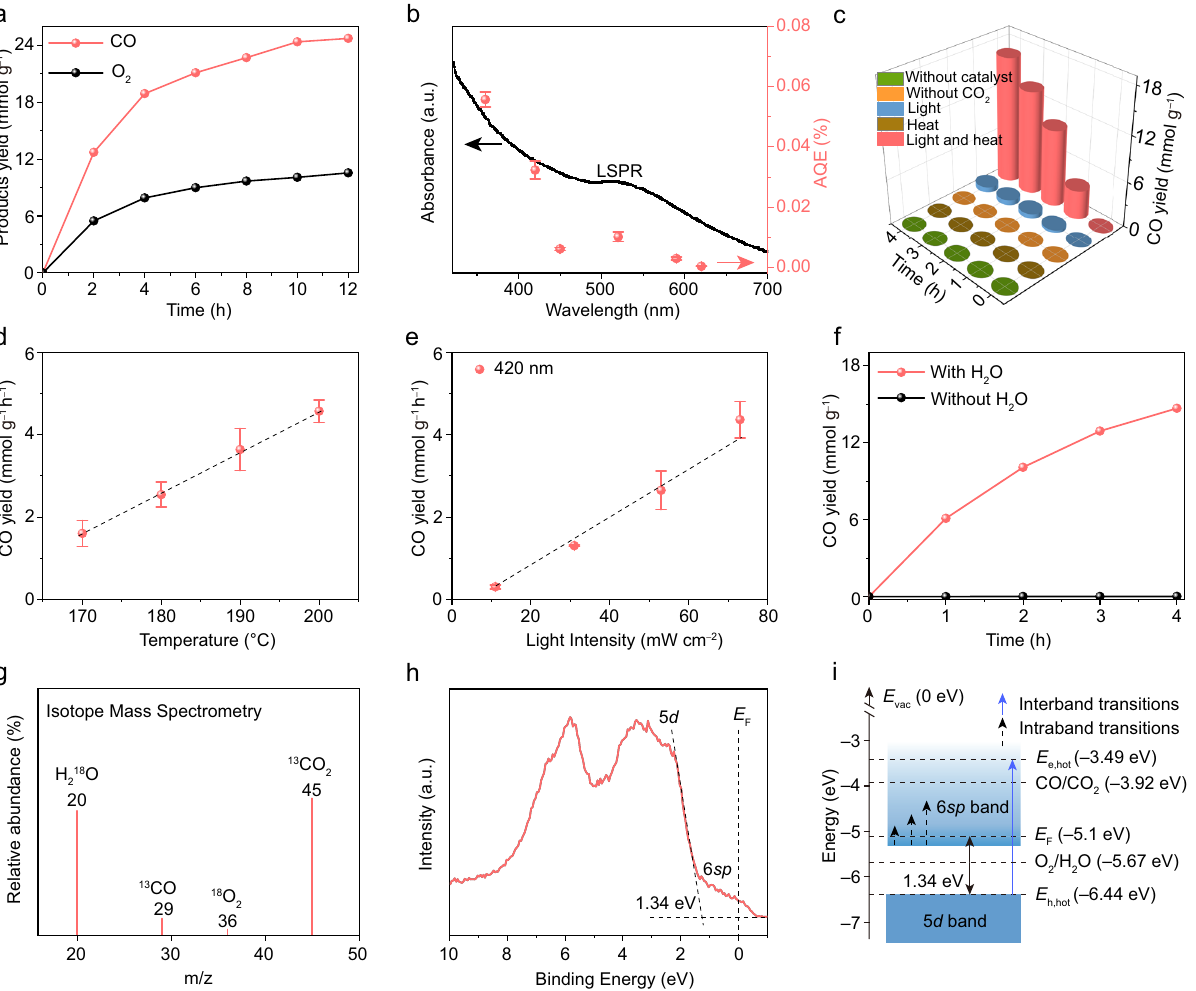
Fig. 2 CO 2 RR performance. a CO and O 2 productions over Au NPs with 420 LED light irradiation at 200 °C. b Wavelength-dependent AQEs of the Au photocatalyst ( n = 3, error bars: standard deviation). c Control experiments with different reaction conditions. d The reaction temperatures and e light intensity-dependent CO production rate on Au NPs under 420 nm LED light irradiation ( n = 3, error bars: standard deviation). f Photocatalytic CO 2 RR performance with (red curve) or without (black curve) H 2 O on Au NPs. g Mass spectrum from GC-MS analysis of the 13 CO and 18 O 2 generated from photocatalytic 13 CO 2 RR with H 2 18 O over Au NPs. h Valence-band XPS spectrum of Au. i Schematic illustration for the electronic band structure of the ~4 nm Au